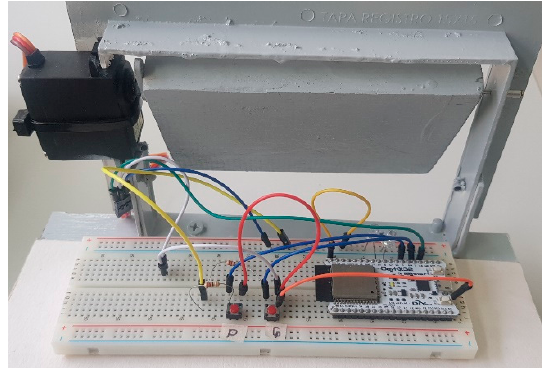
Figure 2. Implementation of ESP32 with servo